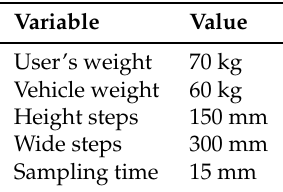
Figure 16. Position profiles of the center of mass of the SCMS used in the ( a ) first and ( b ) second experiments. Table 3. Specifications of the SCMS.